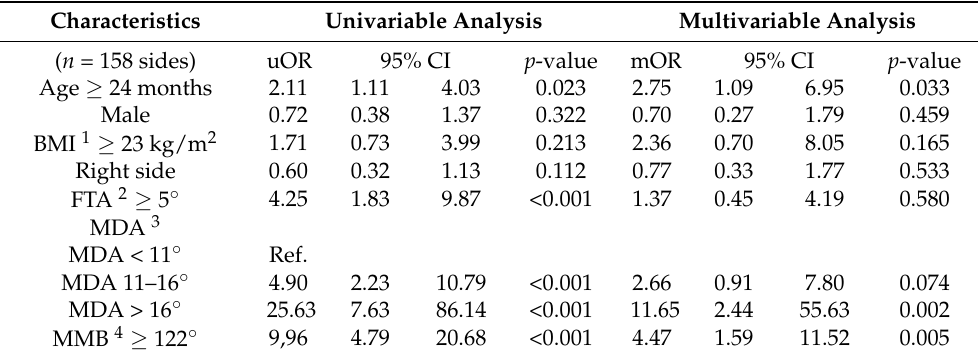
Table 3. Univariable and full model multivariable logistic regression analysis for an independent diagnostic predictor of Blount’s disease (imputed dataset n =